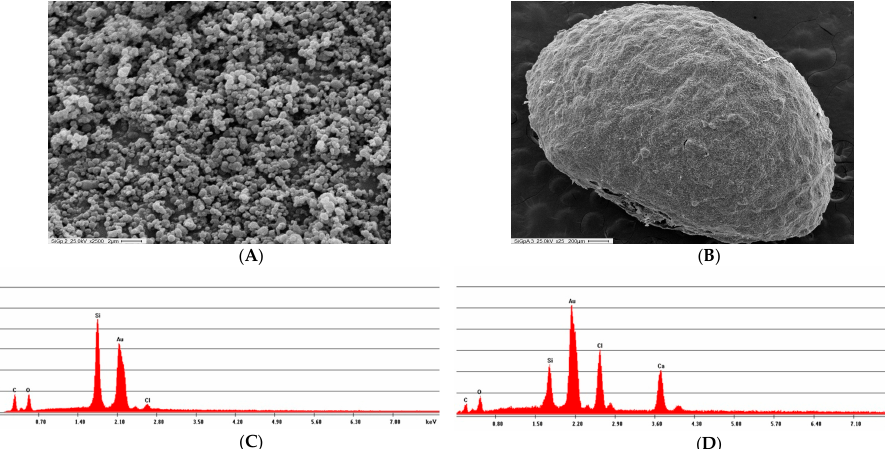
Figure 6. SEM and EDX analysis of SiG PEI25000 - Ld NDT ( A , C ) and SiG PEI25000 - Ld NDT-Alg ( B , D )